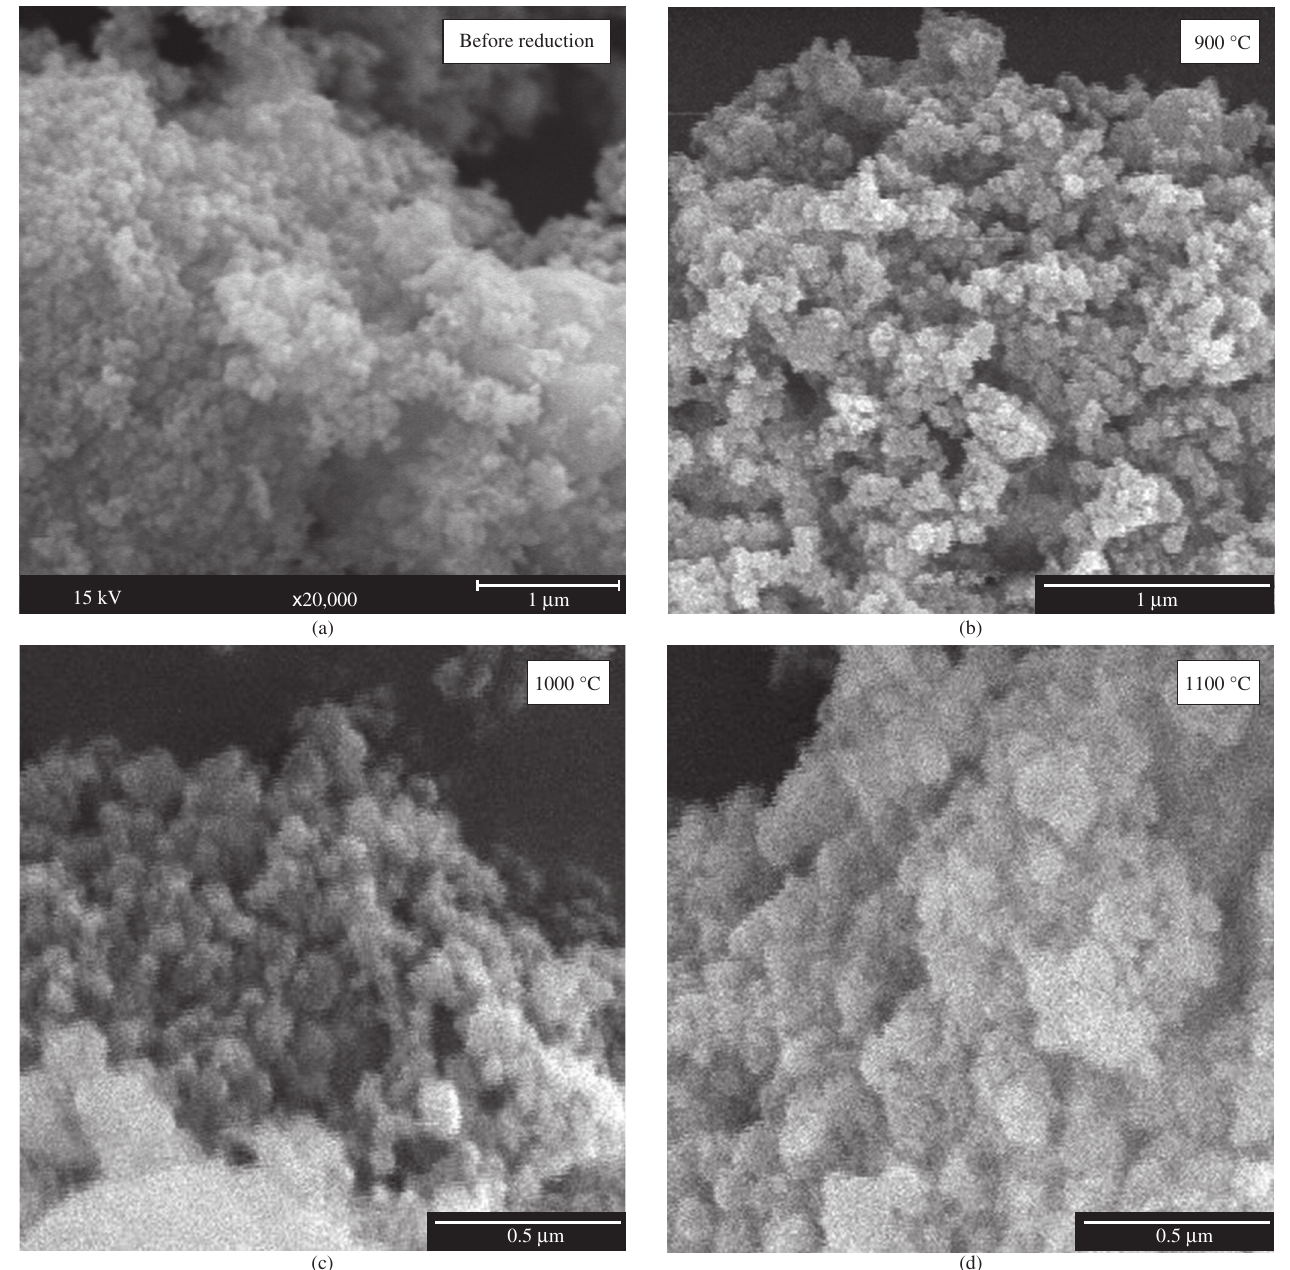
Figure 8. SEM analysis of the samples LaFe